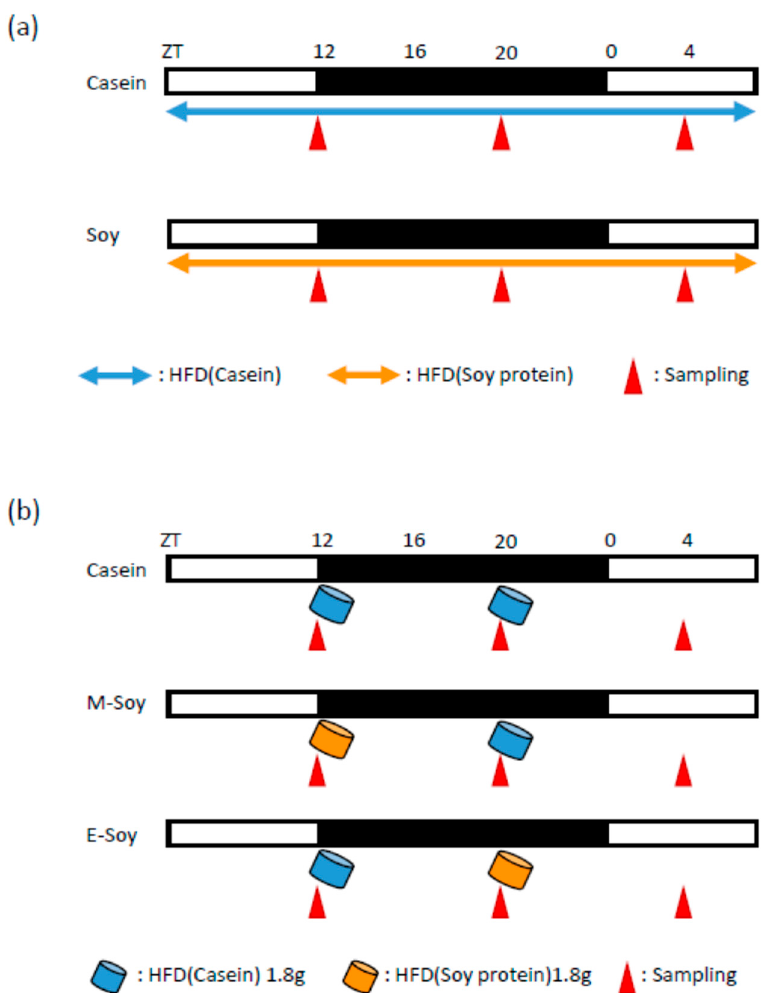
Figure 1. Experimental design. ( a ) Experimental protocol to examine the e ff ect of soy protein intake. ( b ) Experimental protocol to examine the e ff ect of soy protein intake timing. The white and black bars indicate environmental 12 h light and dark conditions, respectively. The horizontal blue arrow indicates free access to a high-fat diet (HFD) with casein. The horizontal orange arrow indicates free access to HFD with soy protein. The blue cylinder indicates the feeding timing of 1.8 g of HFD with casein. The orange cylinder indicates the feeding timing of 1.8 g of HFD with soy protein. The red triangles indicate the sampling time. High-fat diet, casein diet feeding, soy protein diet feeding, morning soy protein diet feeding, evening soy protein diet feeding: HFD, Casein, Soy, M-Soy, E-Soy, respectively.